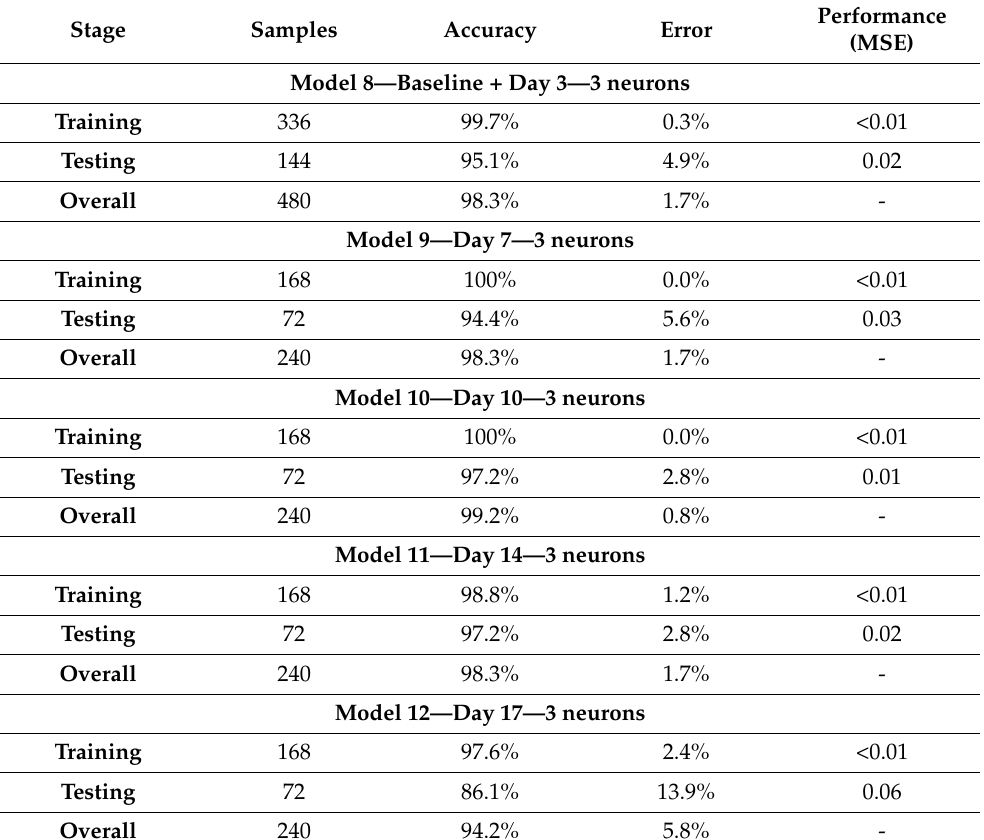
Table 4. Machine learning pattern recognition models based on artificial neural networks (Bayesian Regularization) to classify samples into infestation treatment levels using the electronic nose outputs as inputs. Abbreviations: MSE: means squared error.